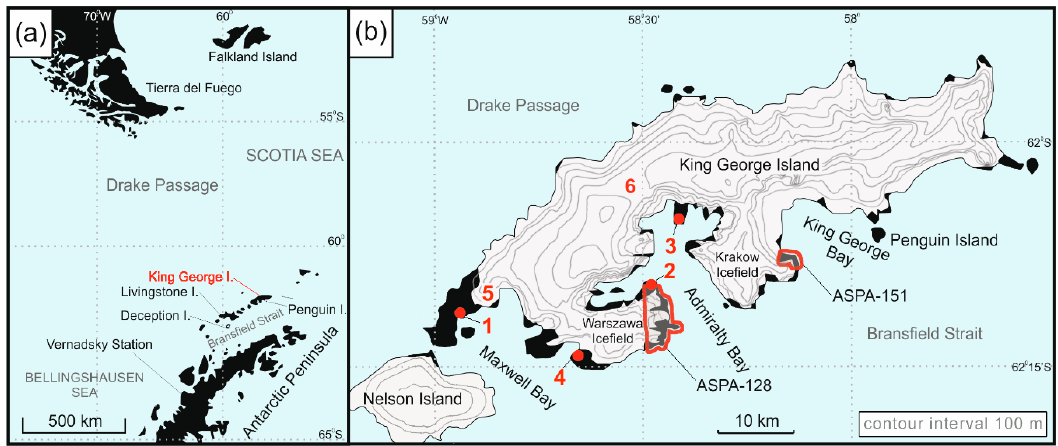
Figure 1. The study area: ( a ) the location of King George Island in West Antarctica, ( b ) the location of the ASPA-128 and ASPA-151 on King George Island; glaciated areas indicated by light grey color, ice-free areas are in black; 1-Bellingshausen Station, 2-Arctowski Station, 3-Ferraz Station, 4-Jubany Station, 5-Fildes Peninsula, 6-Arctowski Icefield.